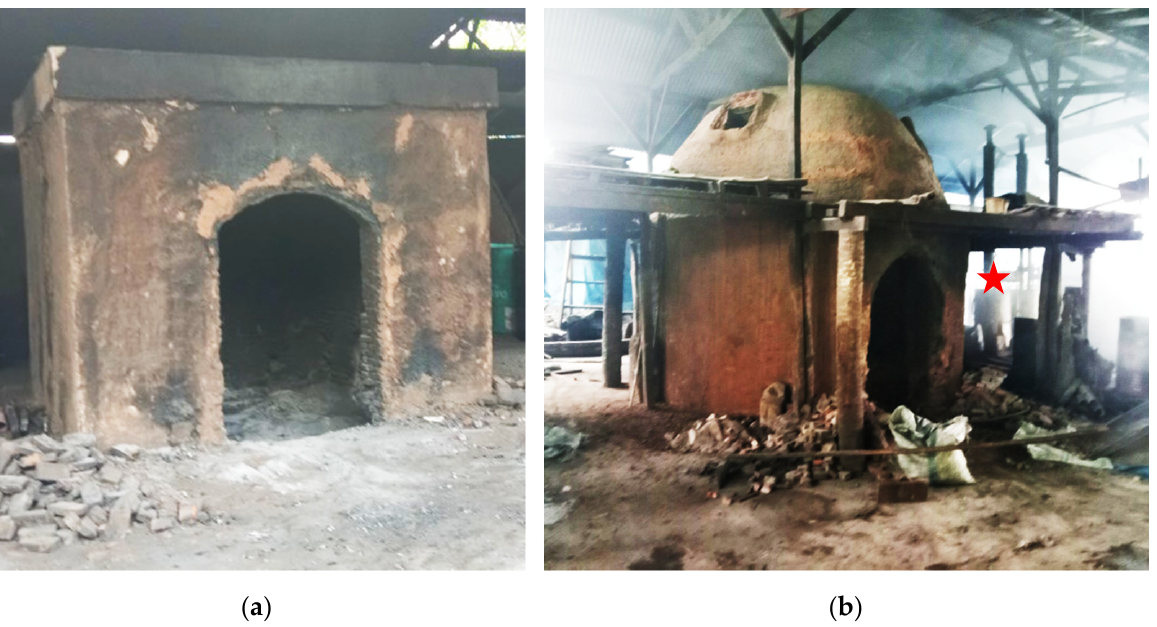
Figure 1. (a) Box furnace and ( b ) dome furnace. The red star symbol at ( b ) is the condenser system.